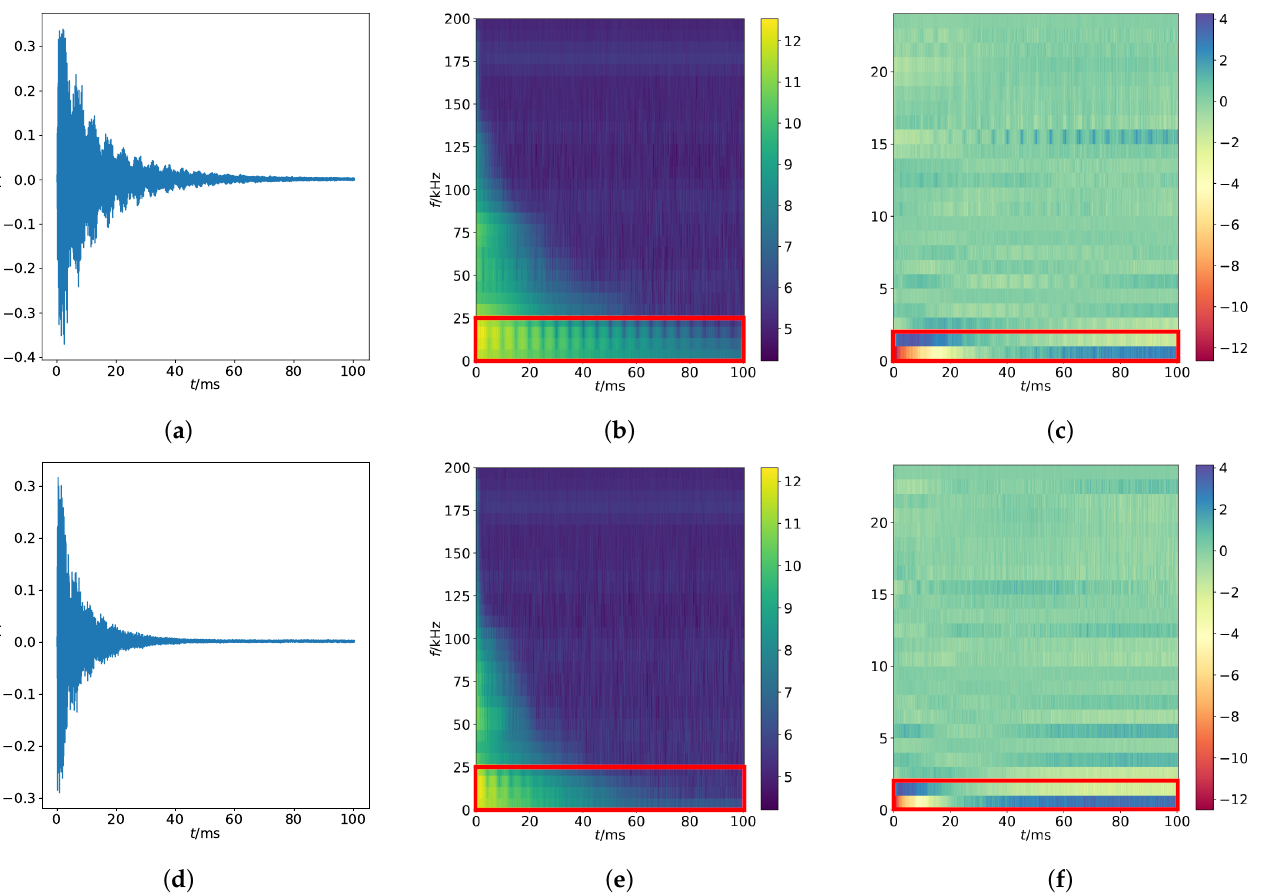
Figure 2. Signals of an intact and a defective sample and corresponding spectrograms of PFA and SFA for Crp1k-200k. For comparison between intact and defective samples, the most noticeable regions are marked with red boxes: ( b ) vs. ( e ) (second column) and ( c ) vs. ( f ) (third column). ( a ) Signal with an intact sample; ( b ) PFA of ( a ); ( c ) SFA of ( b ); ( d ) Signal with a defective sample; ( e ) PFA of ( d ); ( f ) SFA of ( e